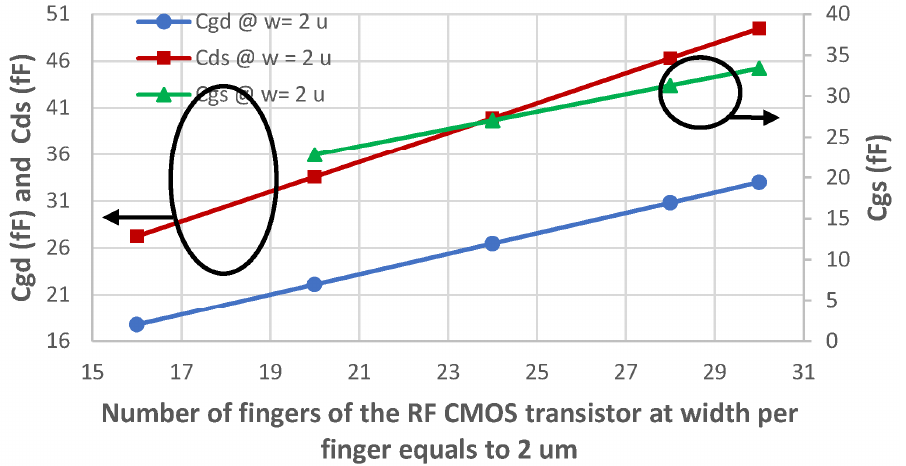
Figure 3. Estimated extra parasitic gate-to-drain capacitance, extra parasitic drain-to-source capaci- tance, and extra parasitic gate-to-source capacitance versus MOSFET’s number of fingers (N) at width per finger equals 2 𝜇𝑚 .